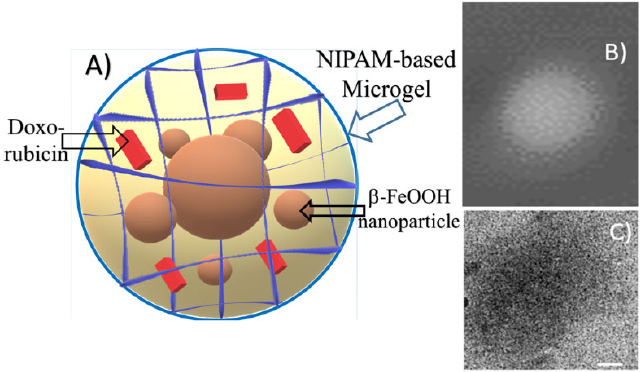
Figure 8. NIPAM ‐ PAA ‐β‐ FeO(OH) ‐ DOX structure—schematical representation ( A ), AFM ( B ), and Figure 8. NIPAM-PAA- β -FeO(OH)-DOX structure—schematical representation ( A ), AFM ( B ), and Cryo ‐ TEM images ( C ). White bar on the left upper image corresponds to 40 nm. Cryo-TEM images ( C ). White bar on the left upper image corresponds to 40